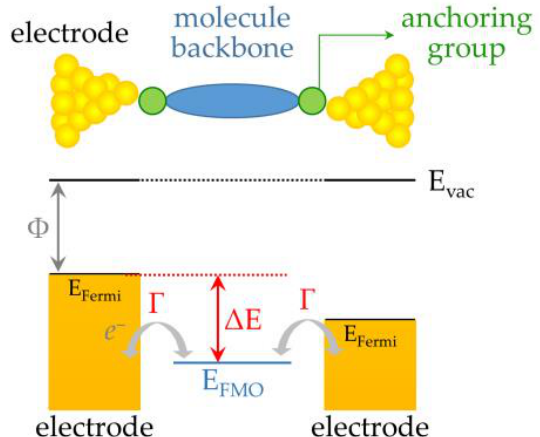
Figure 2. Scheme of a single-molecule junction with a molecule bridged between a pair of electrodes. The lower panel depicts the electrode–molecule coupling, Γ , and the degree of energy-level alignment, ∆ E, namely, the difference between E Fermi and E FMO , where E Fermi and E FMO denote the energy of the Fermi level and frontier molecular orbital, respectively.